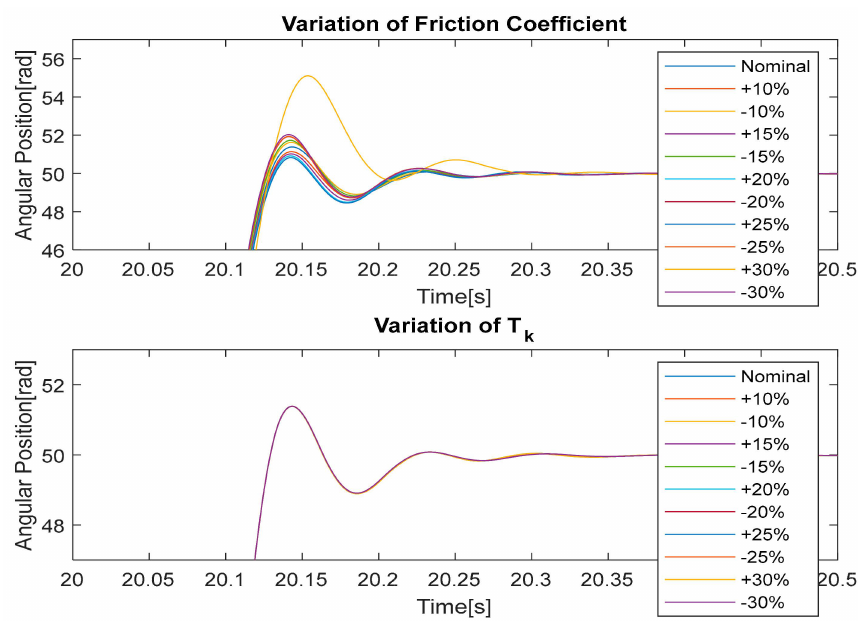
Figure 14. Robustness analysis in terms of variation of the parameters β ( friction coe ffi cient ) and T k .